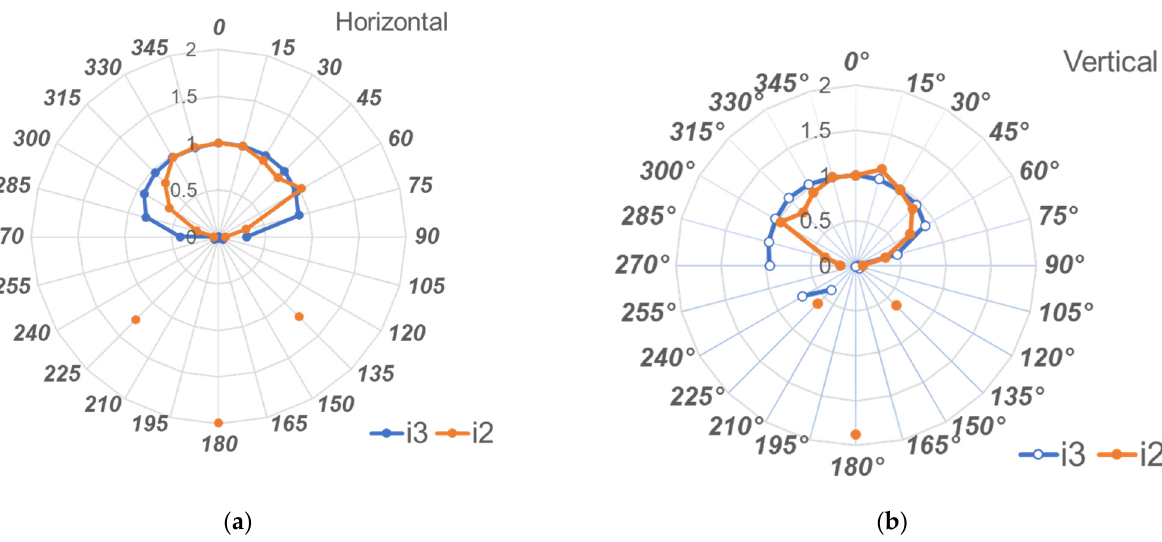
Figure 9. Angle dependencies of the i3 and i2 sensors: ( a ) Horizontal plane; ( b ) Vertical plane.